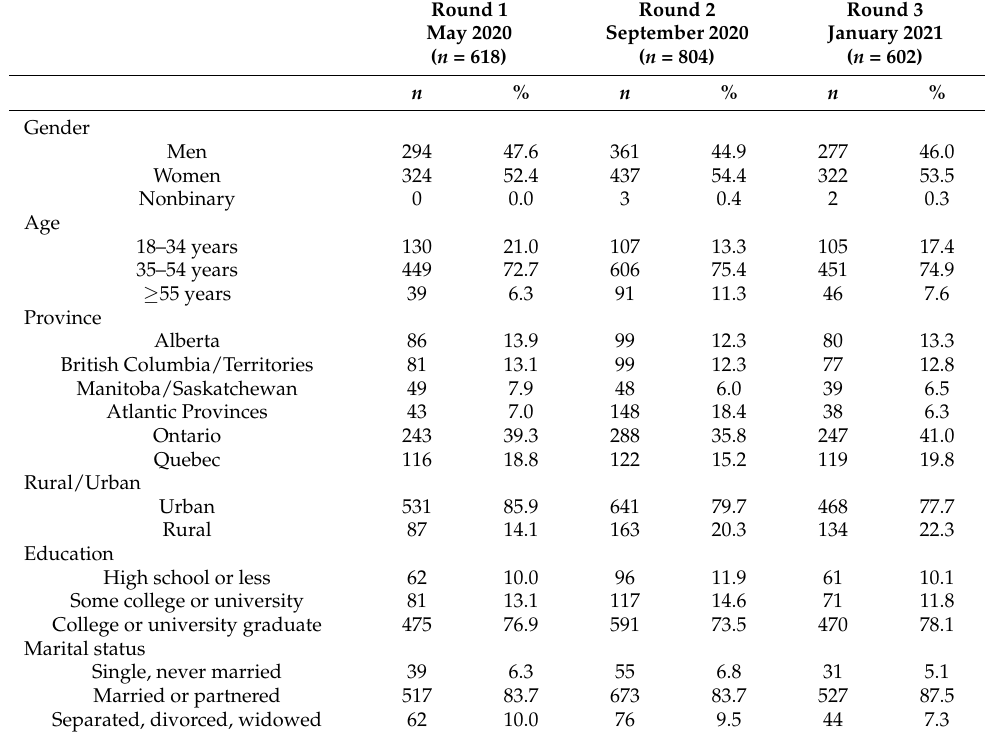
Table 1. Sociodemographic characteristics of the parent sample, by survey